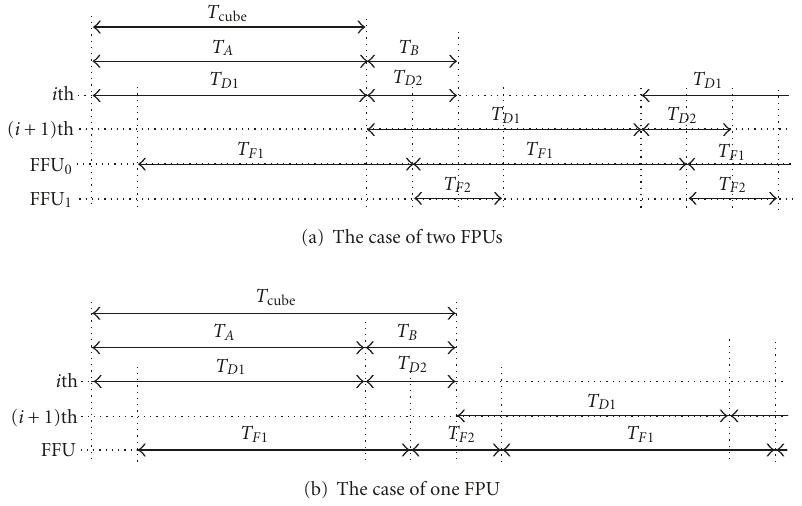
Figure 11: Execution flow with